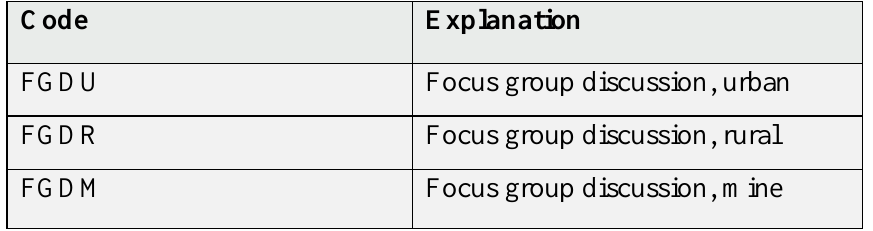
Table 5.4: Codes of individual focus group discussions with girl learners